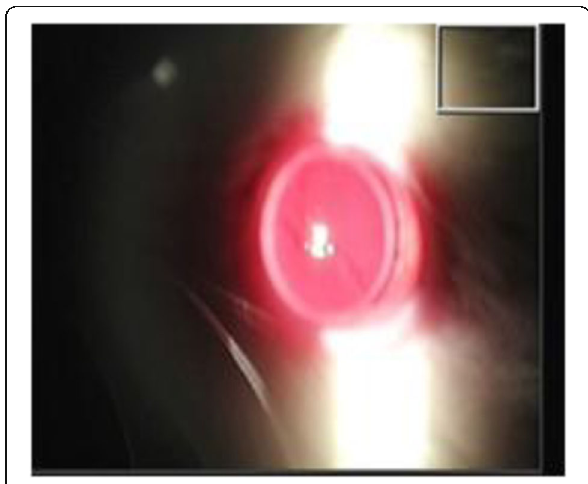
Fig. 3 Slit lamp photography of group 3 (diabetic model treated with 4-PBA) showing clear lens